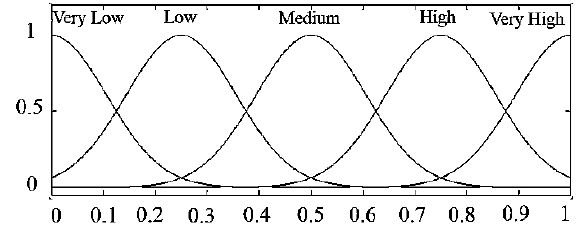
Figure 4. Using Gaussian membership functions to extract output of